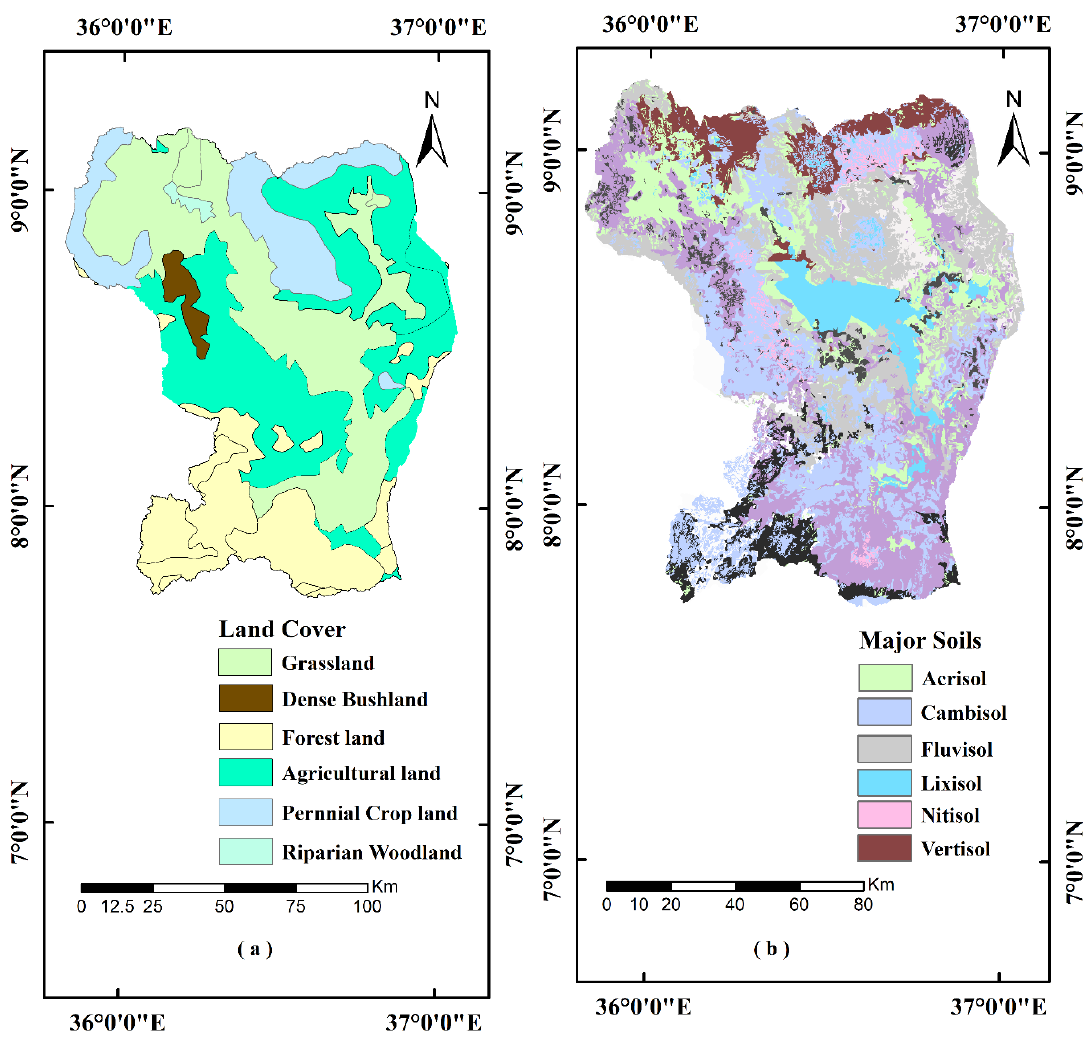
Figure 3. Physiographic data (land use, land cover and major soil